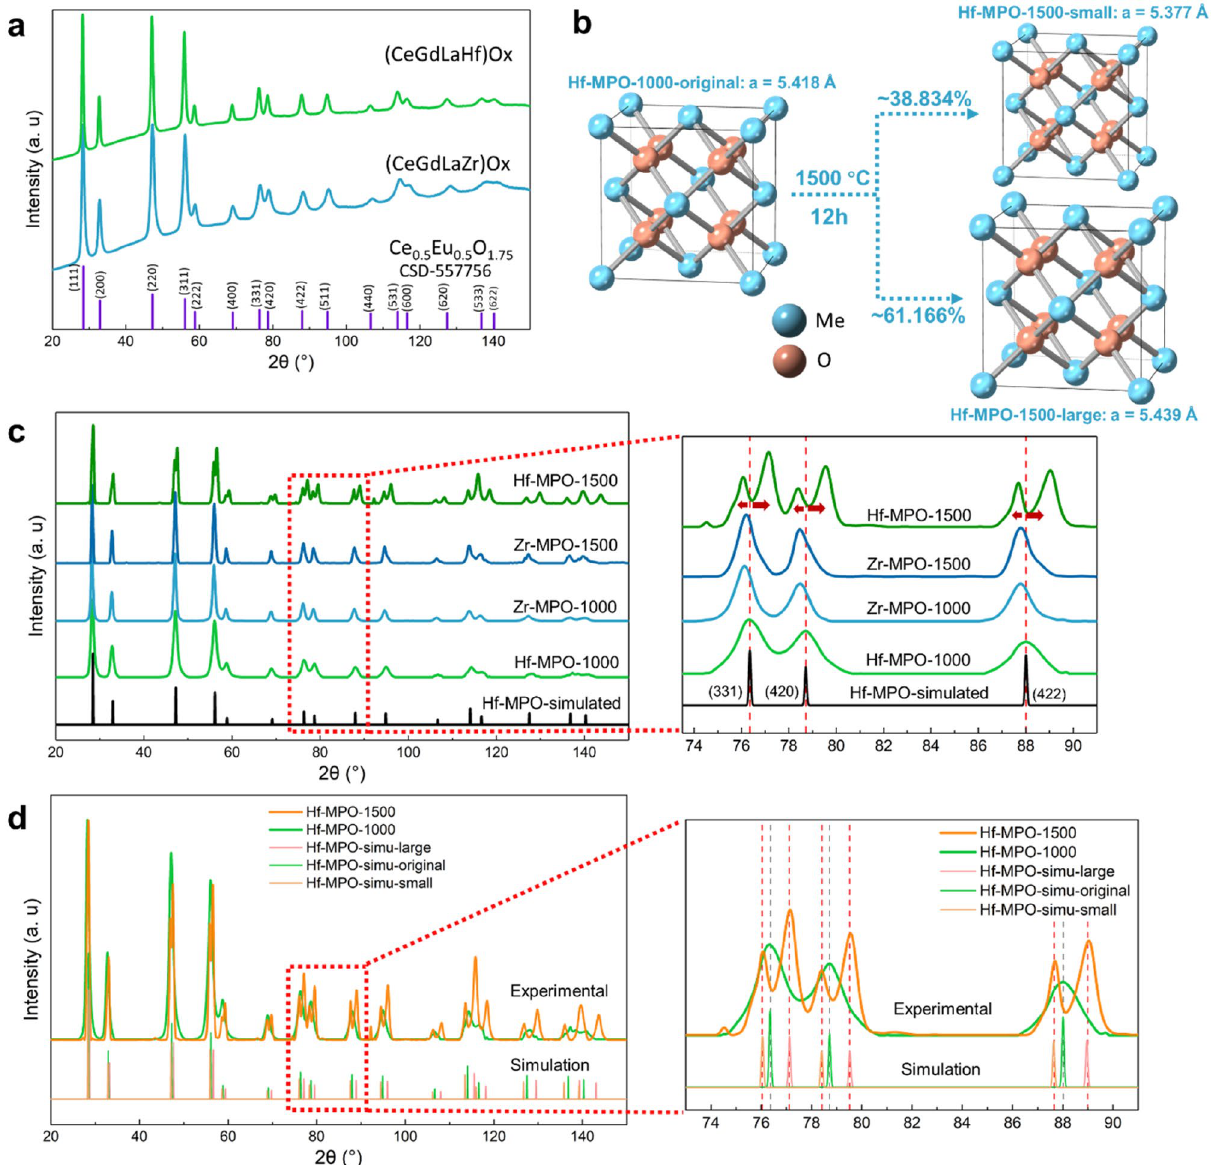
of Hf-MPO-1500, Zr-MPO-1500, Zr-MPO-1000, Hf-MPO-1000 overlaid with simulated Hf-MPO’s profile. ( d ) Comparison of the experimental XRD profiles of Hf-MPO-1500 and Hf-MPO-1000 with simulated XRD of the Hf-MPO-simu-small and Hf-MPO-simu-large and a single phase of Hf-MPO-simu-original